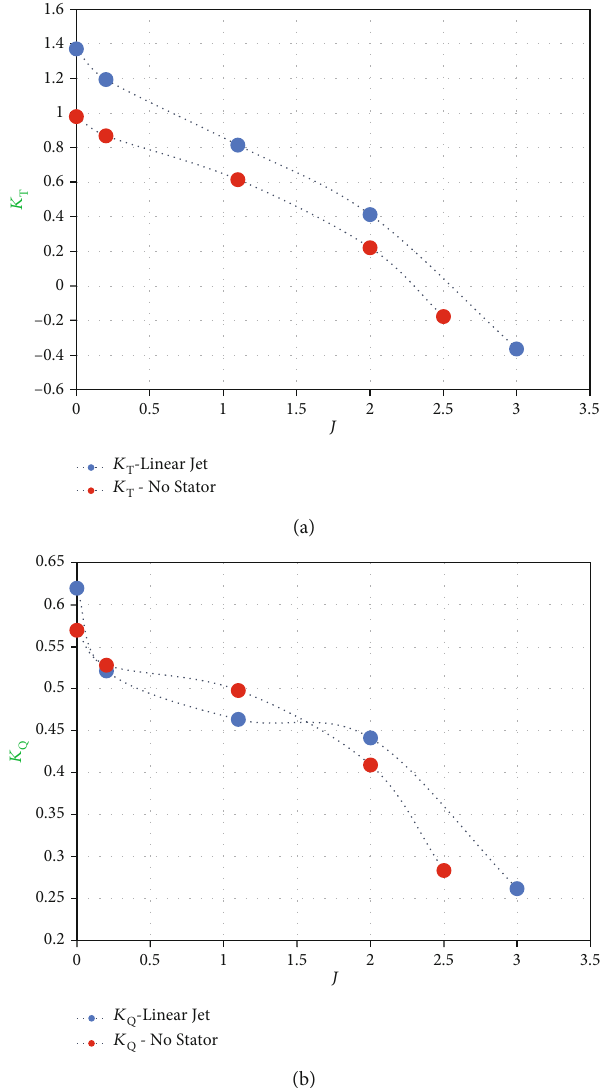
Figure 13: Comparison of forces in the presence and absence of a stator: (a) thrust coe ffi cient; (b) torque coe ffi cient.